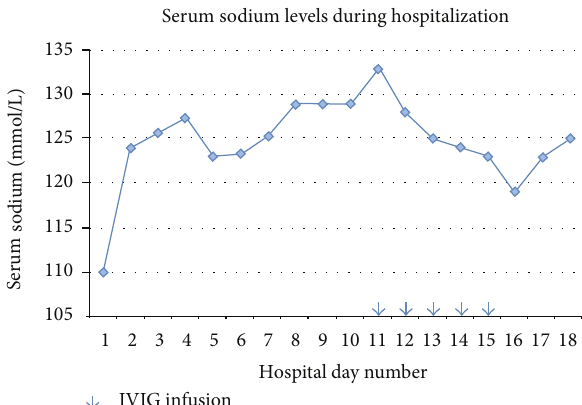
Figure 1: Serum sodium levels during the hospitalization. Arrows indicate IVIG doses given on the respective hospital days. Serum sodium levels were generally obtained in the morning. IVIG infusion was given in the